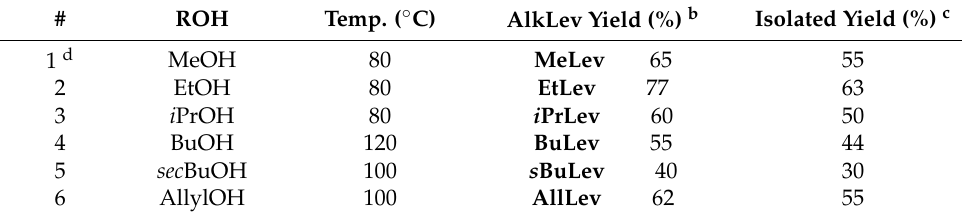
Table 4. Synthesis of alkyl levulinates a